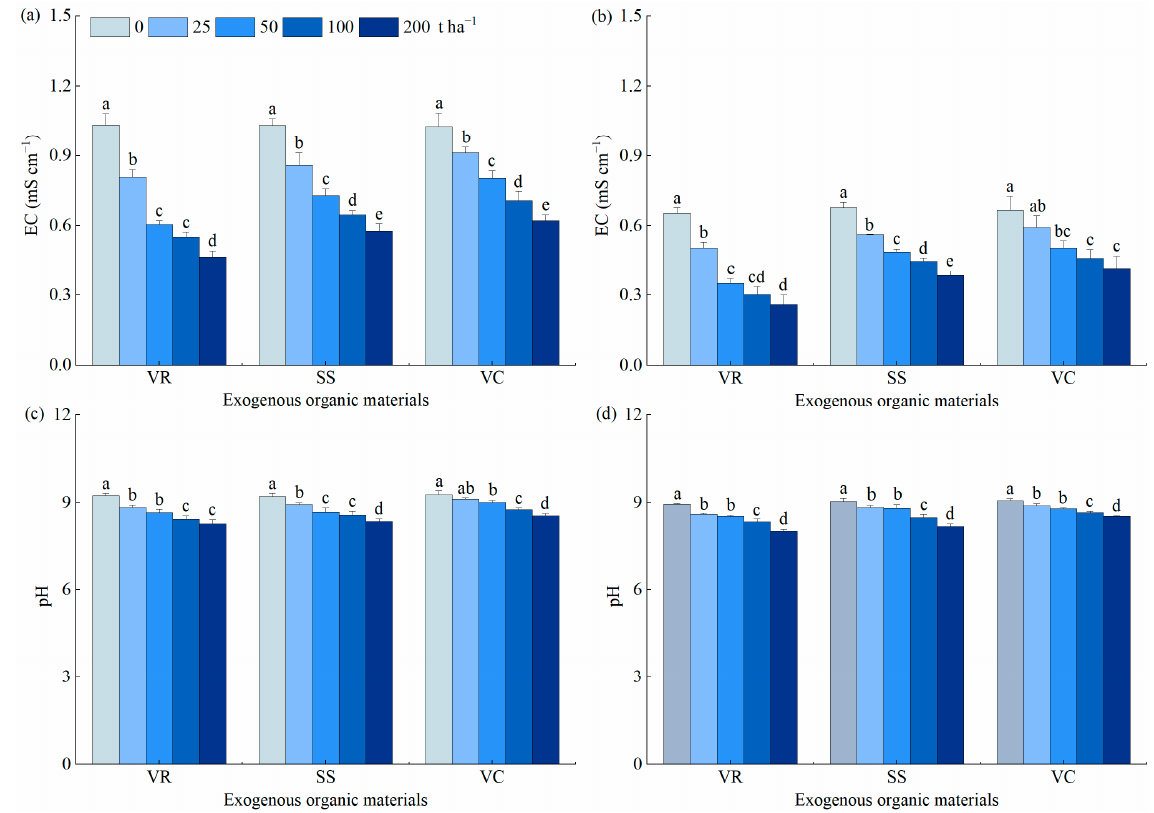
Figure 2. Effect of different organic material application on soil EC and pH in saline-alkali soil: ( a , b ), soil EC in 2020 and 2021, respectively; ( c , d ), soil pH in 2020 and 2021, respectively; VR, vinegar residue; SS, sewage sludge; VC, vermicompost; OM, organic material; EC, electrical conductivity. The vertical bars denote standard errors. Different small letters denote significant difference at p < 0.05.